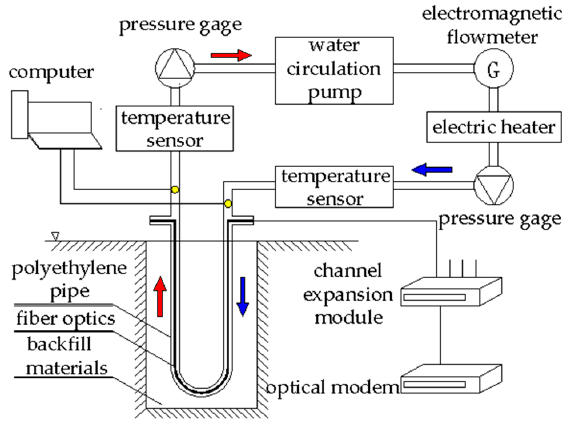
Figure 1. Schematic diagram of the ground source heat pumps (GSHP) system in distributed thermal response test (DTRT).